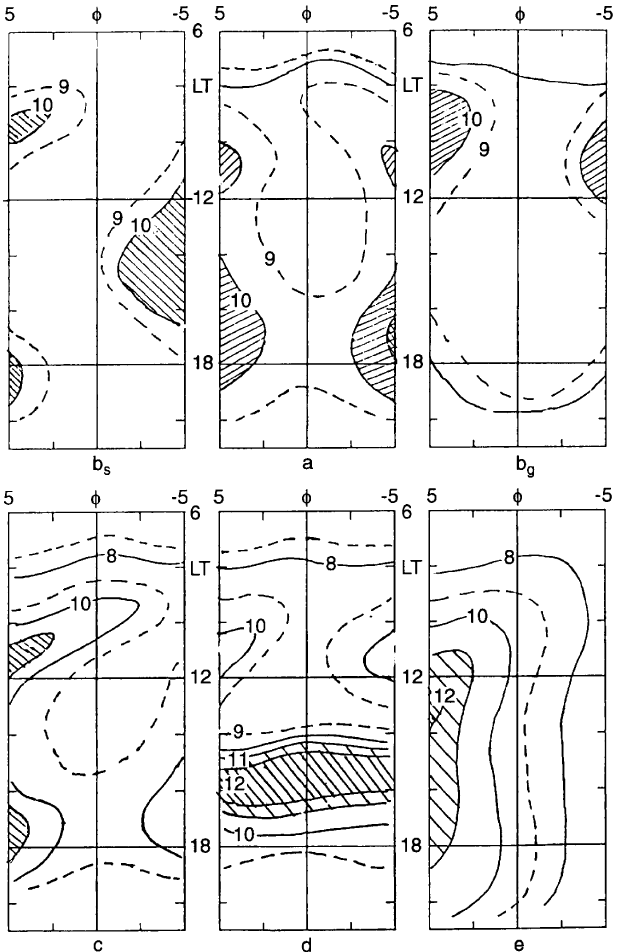
Fig. 2. Classical f oF2 contours at low latitudes showing intertropical crest evolution over the whole (cid:139)20 (cid:176) magnetic latitude for a quiet day 1966, central African network